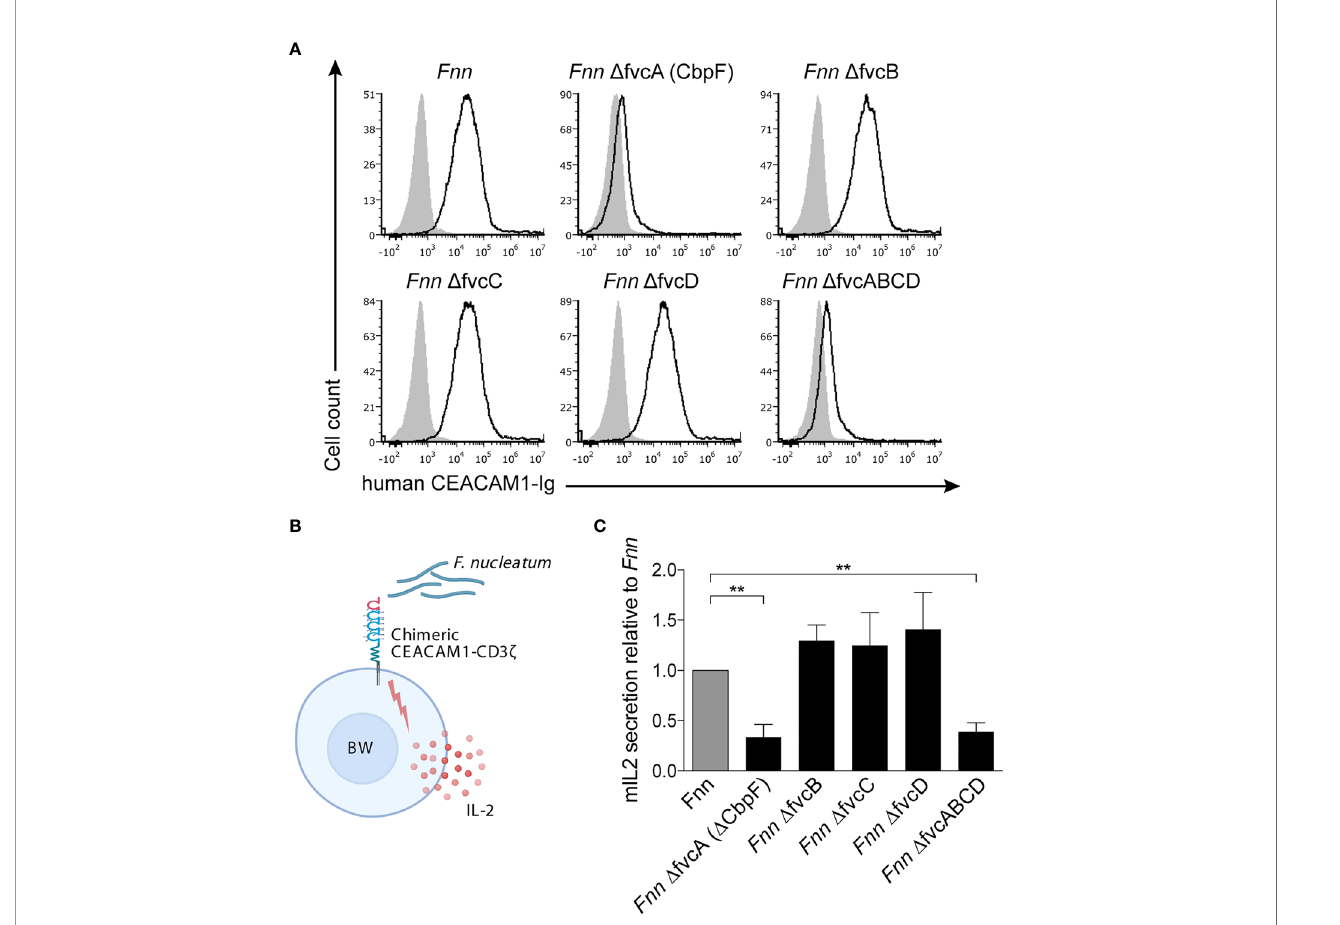
FIGURE 2 | The Fnn Δ CbpF mutant fails to bind CEACAM1. (A) FITC-labeled Fnn and single mutants of the trimeric autotransporter adhesins fvcA (cbpF), fvcB, fvcC, fvcD, as well as a mutant lacking all four adhesins ( Fnn fvcABCD) were stained with 3 m g of human CEACAM1-Ig. 721.221 cells were used as carrier cells. Filled gray histograms represent staining with secondary antibody only. One representative staining out of two is shown. (B) Schematic representation of the BW reporter assay. BW5147 cells stably transfected with human CEACAM1 fused to the transmembrane and cytoplasmic domain of mouse CD3 z chain (chimeric recptor-CD3 z ) are incubated with above-mentioned Fnn strains. Activation of CEACAM1 by a ligand results in mIL-2 quanti fi ed by ELISA. (C) CEACAM1-expressing BW cells were incubated with Fnn strains at a ratio of 1:300. Mouse IL-2 in the supernatants was determined by ELISA 48 hours later. Bars represent means of three independent experiments performed in triplicates ± SD. Fnn bacteria were arbitrarily set to 1 and other values were normalized accordingly. Statistical signi fi cance was assessed using one-way ANOVA with Dunnett ’ s multiple comparison test. **p ≤